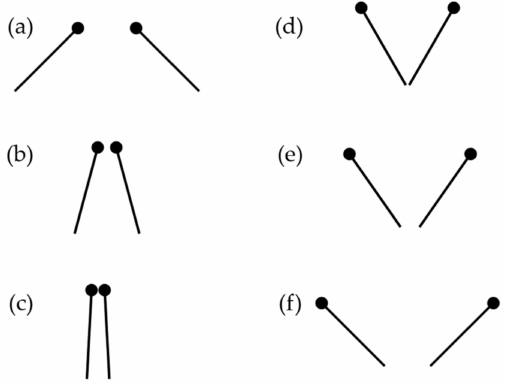
Figure 1. Schematic of wing sections during “clap” ( a – c ) and “fling” ( d – f